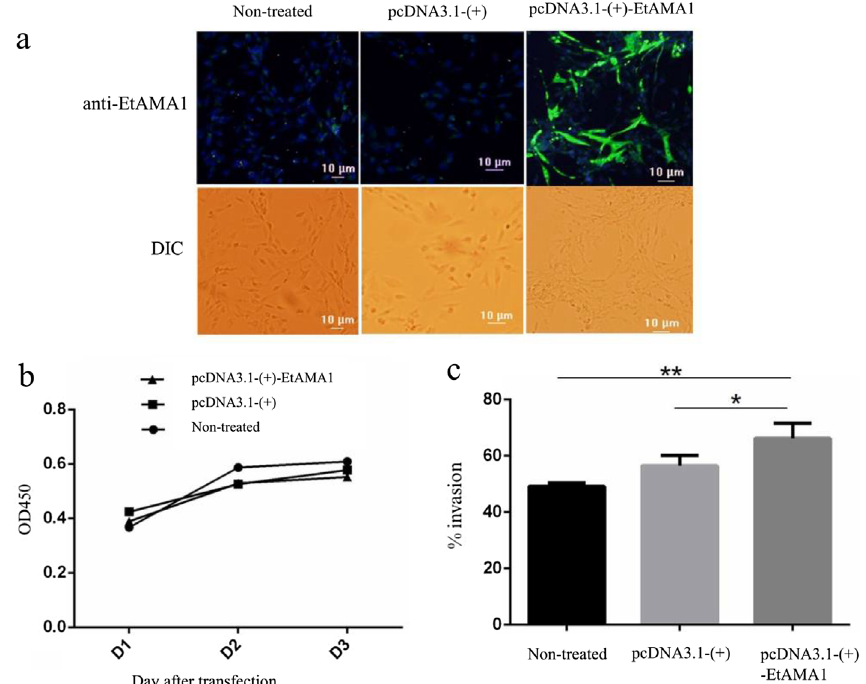
Figure 4. In vitro sporozoite invasion of DF-1 cells transiently transfected with EtAMA1. (a) Veri fi cation of pcDNA3.1-(+)-EtAMA1 expression in DF-1 cells by IFA. (b) The proliferation of DF-1 cells transfected with pcDNA3.1-(+)-EtAMA1 or pcDNA3.1-(+). (c) Sporozoite invasion rate in DF-1 cells transfected with pcDNA3.1-(+)-EtAMA1 or pcDNA3.1-(+). * p < 0.05 and ** p < 0.01, as determined by the Student ’ s t -test versus the untreated